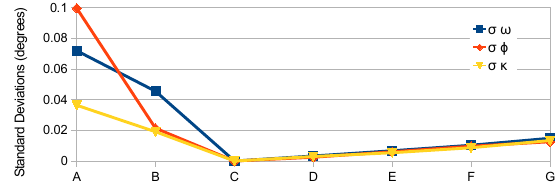
Figure 7. Standard deviations of rotation elements of the Relative Rotation matrix computed from estimated EOP.